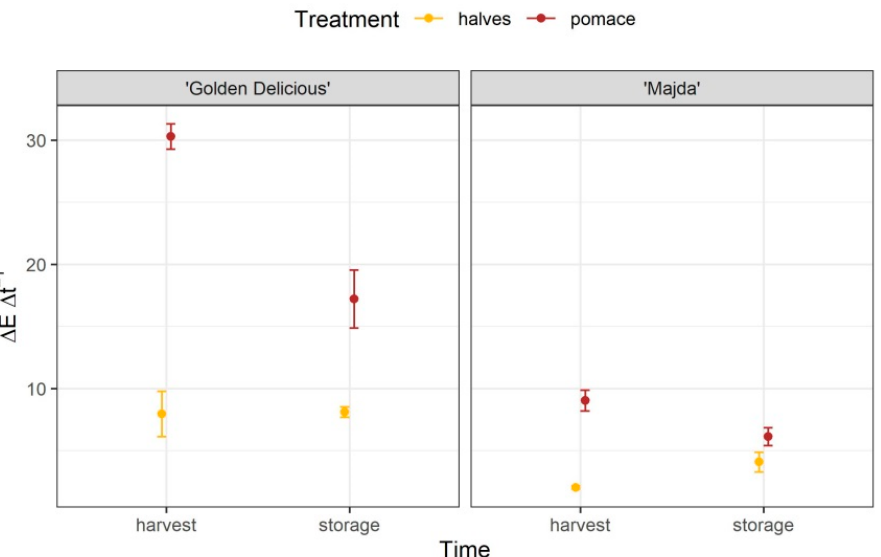
Figure 4. Change in color ( ∆ E ∆ t − 1 ; mean ± SE) of apple halves after 1 h and pomace after 10 min for cultivars ‘Golden Delicious’ and ‘Majda’ at harvest and following storage.